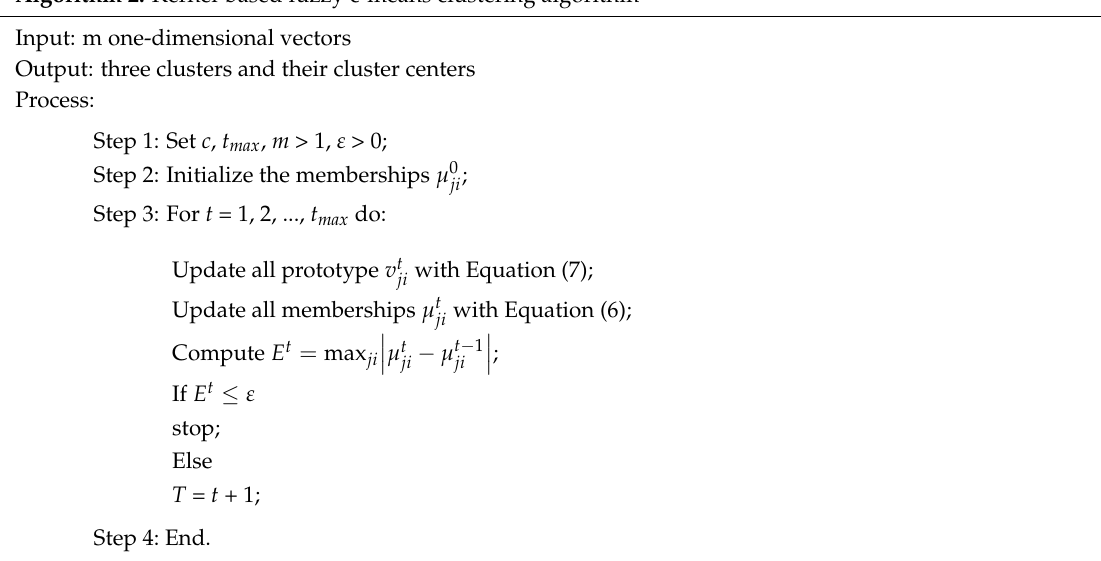
Algorithm 2. Kernel-based fuzzy c-means clustering